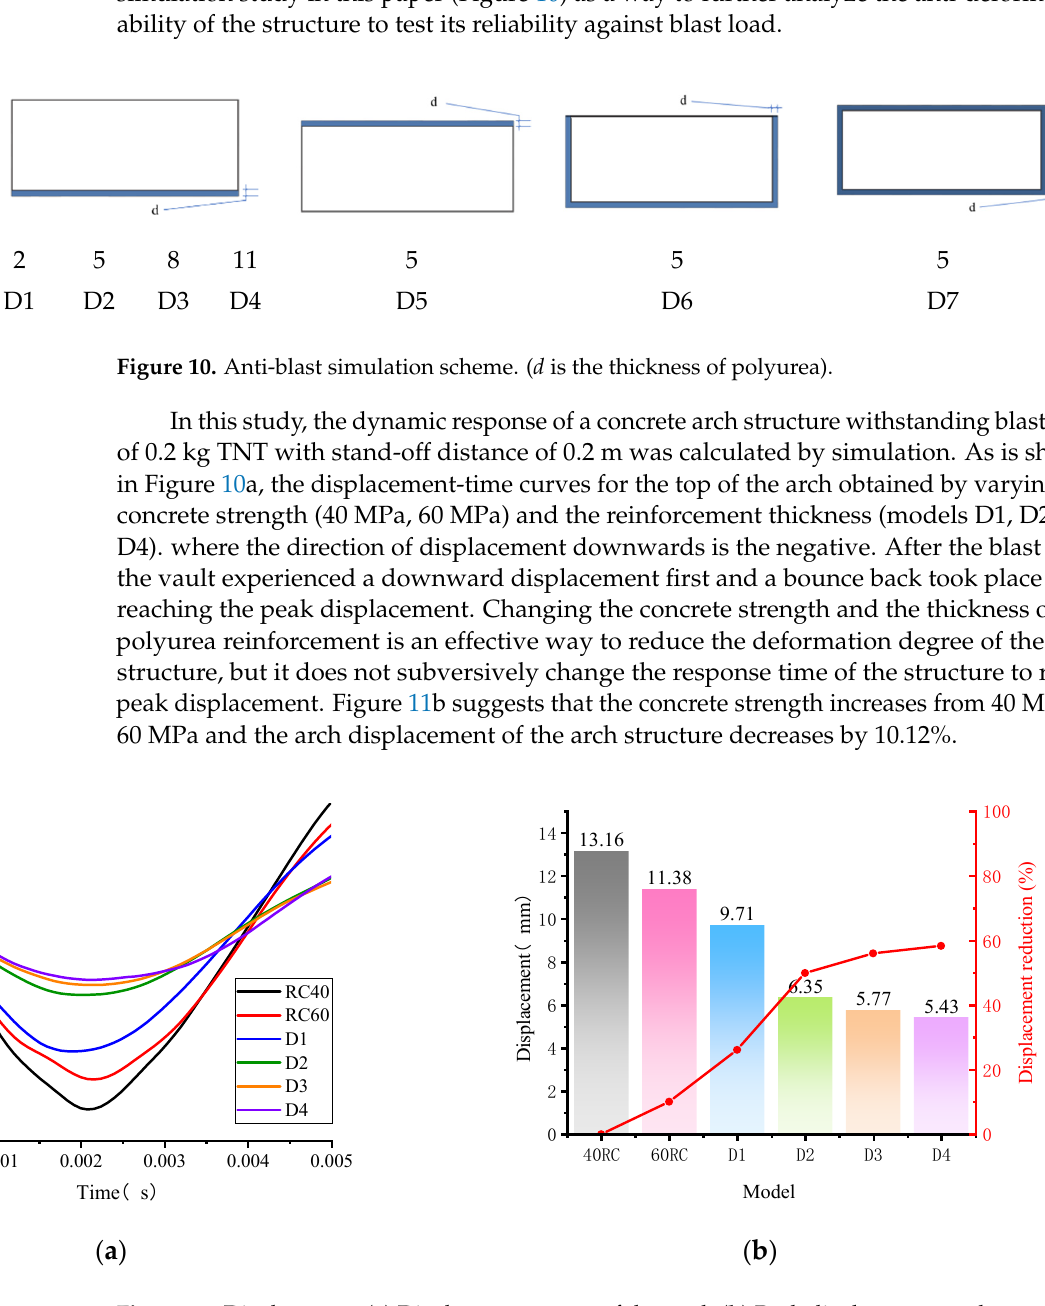
Figure 9. Dynamic acceleration measured at the inner side of the vault of member B1.